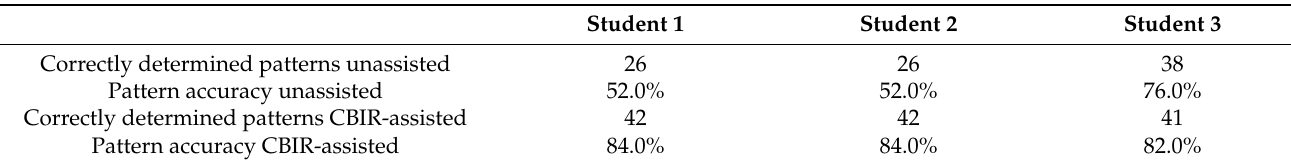
Table 5. Results of the students’ pattern accuracy. Student 1’s and Student 2’s pattern accuracy in the unassisted test runs proved to be significantly different ( p < 0.01) from the CBIR-assisted test runs, while Student 3’s was not significantly different ( p = 0.25).